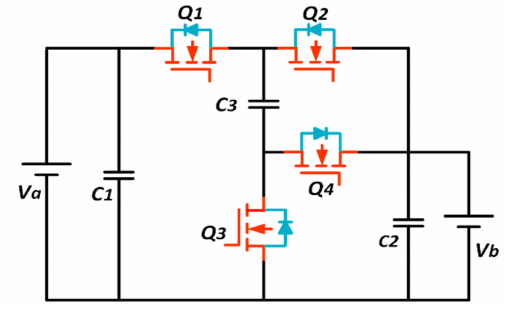
Figure 8. Switched capacitor of bidirectional DC-DC converter